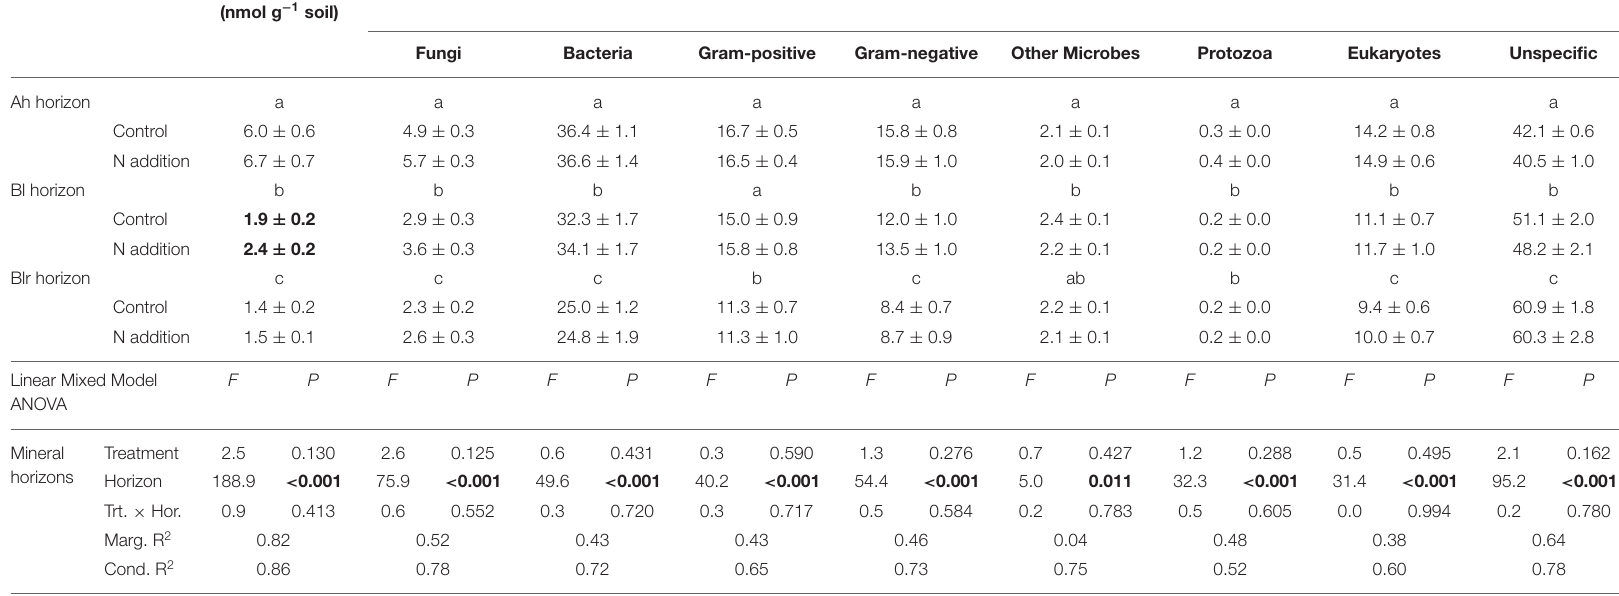
TABLE 3 | Total PLFA concentrations and relative abundance of group-specific PLFA biomarkers (mol%) in response to long-term N addition at Alptal